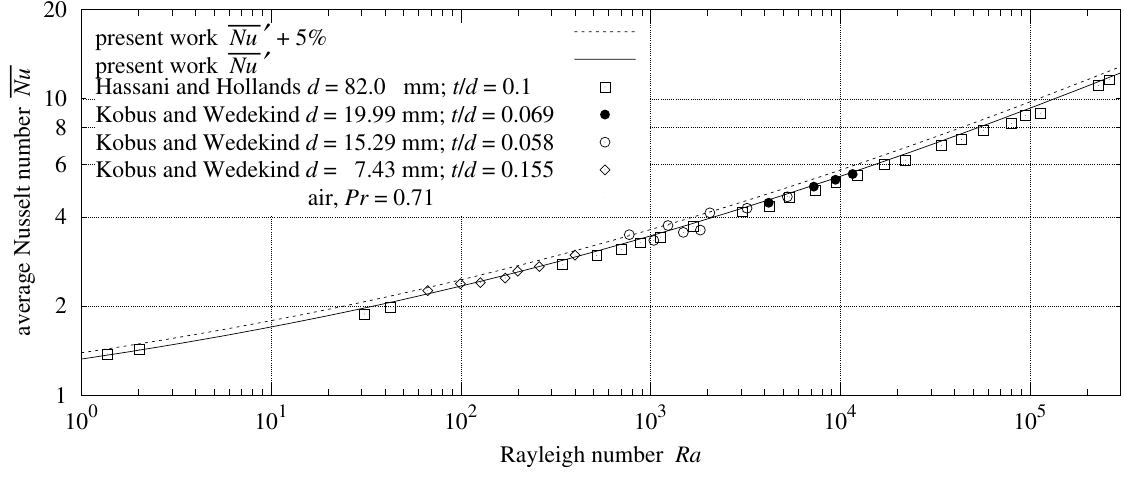
Figure 7. Heat transfer from vertical disk. Figure 7 and Table 8 present the vertical disk heat transfer measurements. Table 8. Heat transfer from vertical